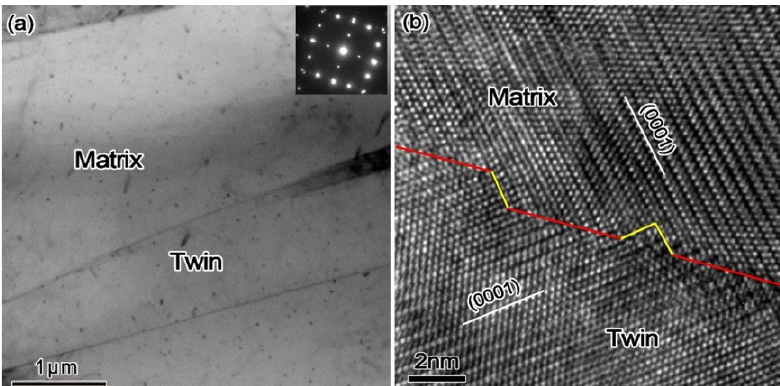
Figure 5. ( a ) Bright field TEM image showing the microstructure feature of 1.3% pre-strained and annealed samples (ERD1.3CA). The electron beam is nearly parallel to the [1120] zone axis. ( b ) HRTEM image showing the interfacial structure of {10 12} twin in sample ERD1.3AC. The (0001) basal planes are denoted by the white lines. The {1012} TB consist of coherent bounda- ries and basal–prismatic interfaces, as marked by the red and yellow lines, respectively.